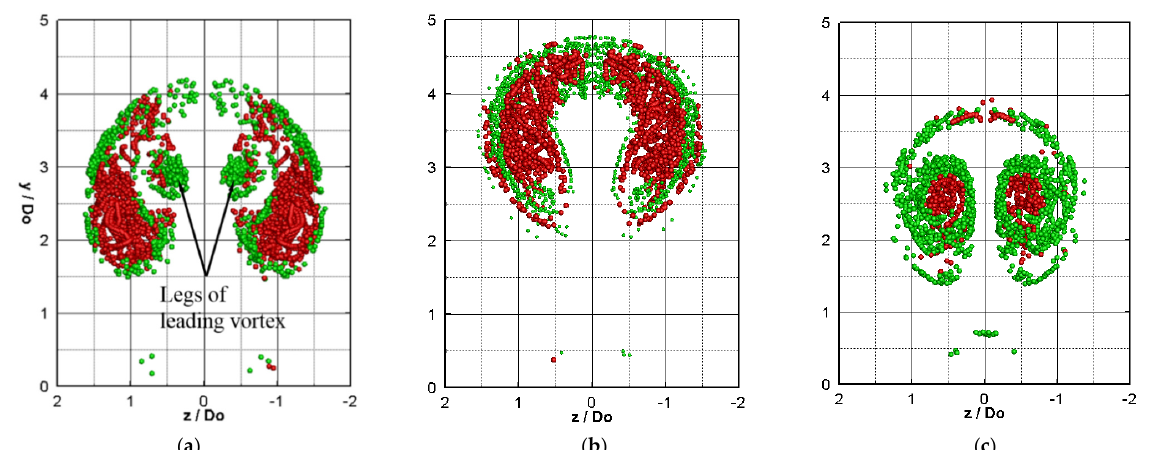
Figure 8. Snapshots of colored fluid particles from the streamwise cross-section view at ( a ) x = 11 D o for the Δ ϕ = 0 case, ( b ) x = 11 D o for the Δ ϕ = π / 2 case and ( c ) x = 9.5 D o for Δ ϕ = π case ( t /T = 0). These streamwise cross-section planes are indicated with dashed lines in Figure 7.